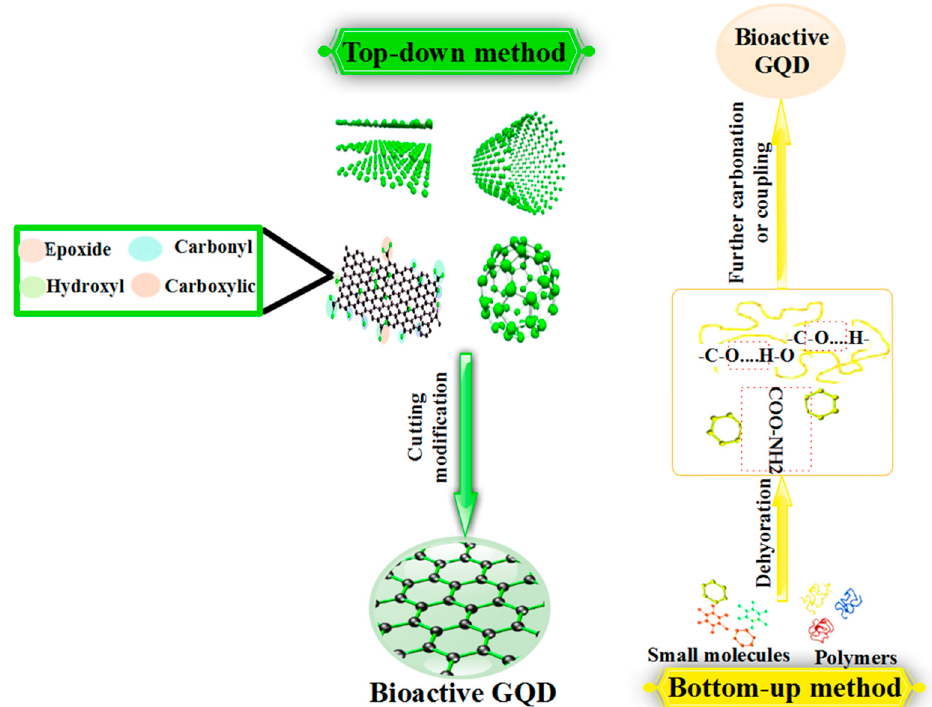
Figure 2. The top-down and bottom-up methods for the synthesis of bioactive GQDs.